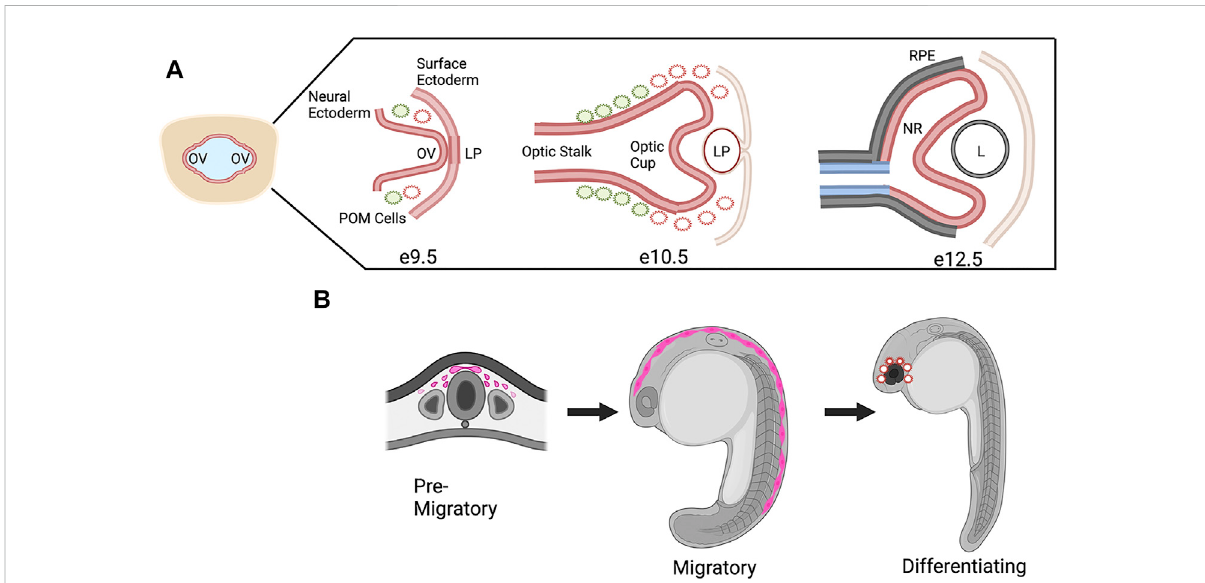
FIGURE 4 CHD7 Expression in Ocular Morphogenesis and Neural Crest Cell Development. (A) Schematic representation of ocular development stages in mouse from optic vesicleevagination at E9.9 to bi-layered optic cup at E12.5, CHD7 expressionis colored in red.OV, optic vesicle; LP, lens placode/ pit; POM, periocular mesenchyme; RPE, retinal pigment epithelium; NR, neural retina; L, lens. (B) Schematic representation of CHD7 expression in neural crest cell development, CHD7 expression is colored in pink. Figure created with